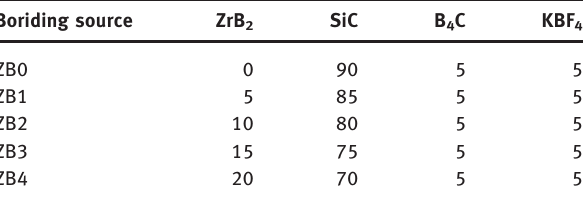
Table 1: Compositions of the different boriding sources (wt.%). Boriding source